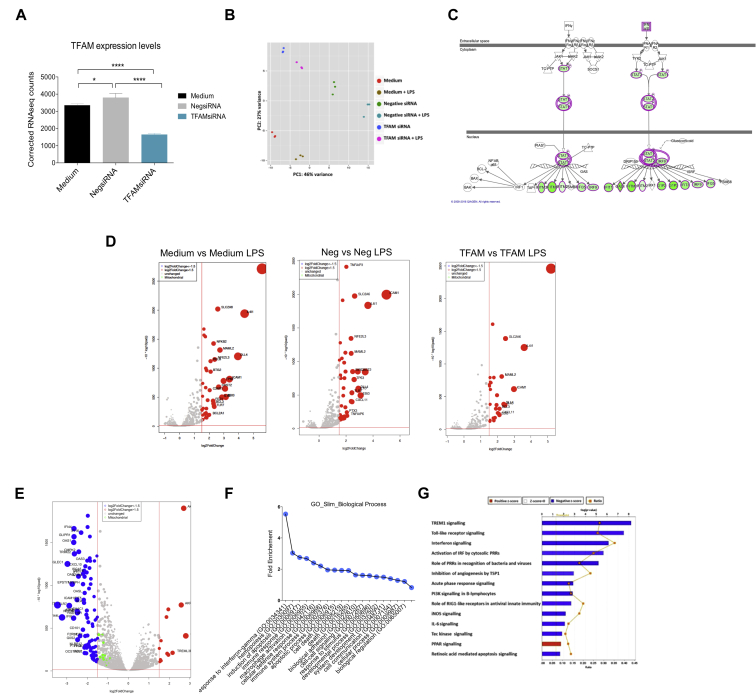
Canonical signaling pathways in mtDNA-depleted THP-1 cells with and without LPS treatment. THP-1 cells were incubated in growth medium or transfected with 30 nmol/L of negative or TFAM siRNA for 8 days. After a final incubation with 100 ng/mL LPS or medium for 4 hours, gene expression was assessed by RNA-Seq. A, Levels of transcripts for TFAM. B, Principal component analysis plot. C, The effect of transfection with TFAM siRNA on the interferon signaling pathway extracted from IPA (downregulated genes are highlighted in green and upregulated genes are highlighted in red). D, Volcano plot showing differentially expressed genes in each experimental condition following treatment with LPS. E, Volcano plot comparing the LPS response of TFAM siRNA-transfected cells to negative control siRNA transfected cells. (In the volcano plots, differentially expressed genes are highlighted in gray, genes with LogFC >1.5 are represented in red [upregulated] or blue [downregulated], while mitochondrial genes are highlighted in green. The size of the dots is proportional to the LogFC.) F, Gene Slim Ontology analysis carried out by Gene Ontology Consortium Fold Change enrichment for pathways with P < .05. G, IPA analysis of the canonical signaling pathways significantly affected by the differential expression of genes after treatment with LPS in TFAM siRNA-transfected THP-1 cells compared with negative siRNA-transfected cells. The data were filtered for Benjamini-Hochberg multiple testing correction P-value <.05 and z-score >±2. *P < .05 and ****P < .0001.